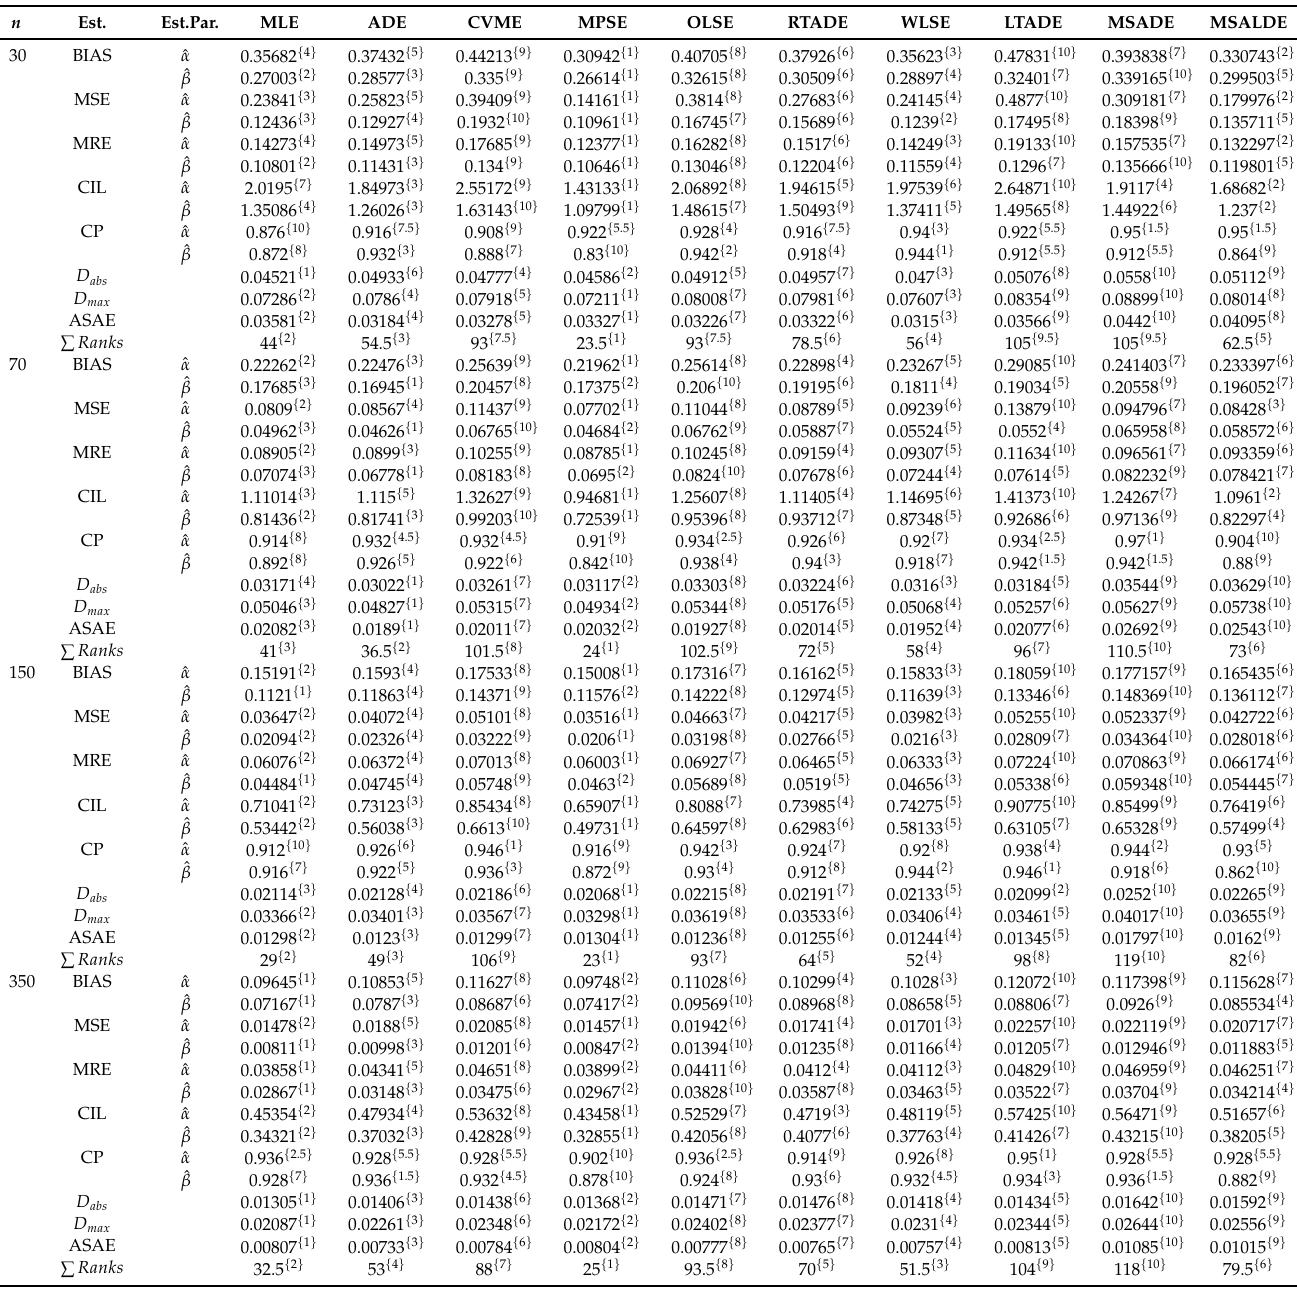
Table 5. Numerical values of PHD simulation for ( α = 2.5, β = 2.5 )